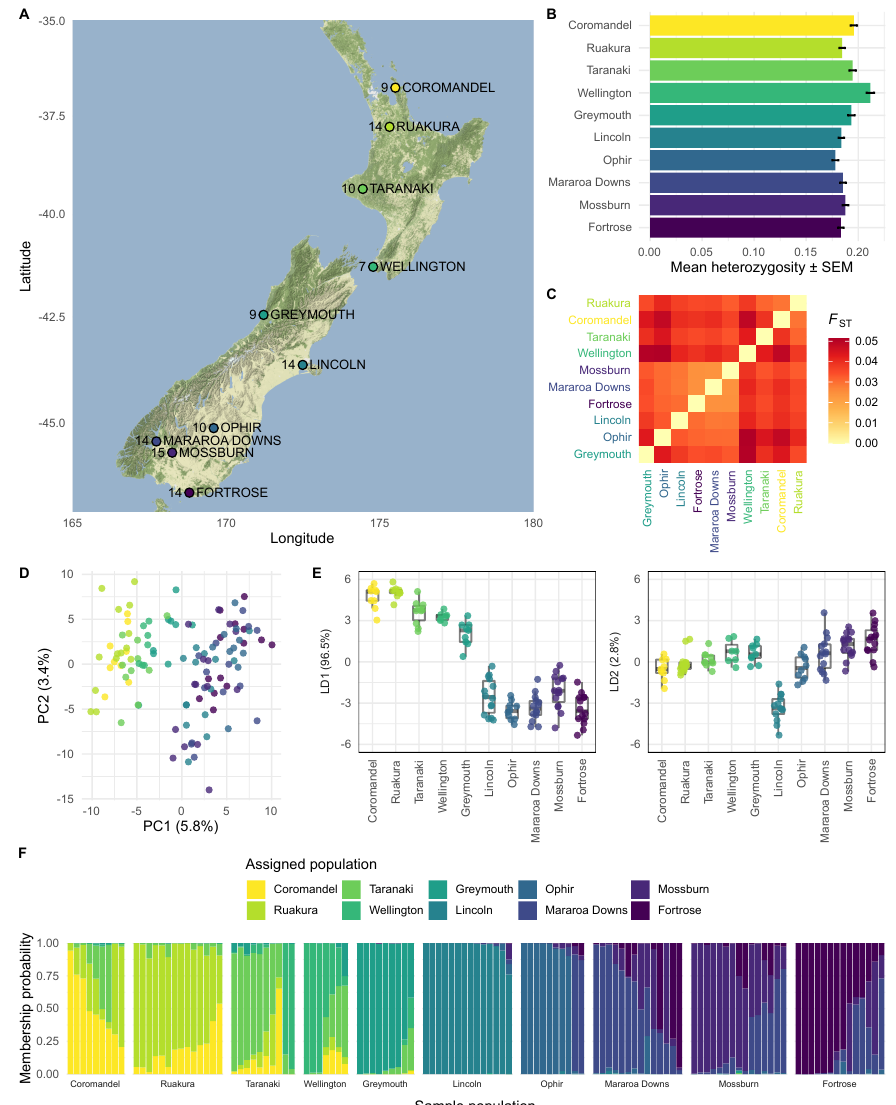
Figure 1. Genetic diversity in NZ populations of Argentine stem weevil. ( A ) Weevil sampling locations. We collected Argentine stem weevils from 4 locations in the North Island and 6 locations in the South Island of New Zealand. Greymouth is in the South Island, but North of the Main Divide, which runs along the Southern Alps and partitions the South Island. The number of weevils genotyped (after filtering) from each location is shown on the map. Map tiles by Stamen Design under CC BY 3.0, with data by OpenStreetMap under ODbL. ( B ) Mean observed heterozygosity for each population. ( C ) Pairwise F ST values between populations. ( D ) Principal components analysis (PCA) describing total variability and ( E ) discriminant analysis of principle components (DAPC) describing between-population variability of 116 individuals genotyped at 18,715 biallelic sites. In the PCA ( D ), populations overlap on the first two principal components (PC1 and PC2), but weevils sampled from higher latitudes have lower scores on PC1. PC1 and PC2 together explain 9.2% of variance in the dataset, indicating a high level of unstructured genetic variation in weevil populations. In the DAPC ( E ), the major linear discriminant (LD1) explains 96.7% of between-group variability. LD1 splits individuals from North and South of the Main Divide. LD2 separates Lincoln individuals from other individuals. ( F ) Posterior probability of group assignment for each individual. All populations contain individuals with high posterior probabilities of membership to other populations. This is consistent with gene flow between populations. We did not detect evidence of gene flow between populations from North and South of the Main Divide. Individuals sampled from Lincoln had the lowest posterior probabilities of membership to other